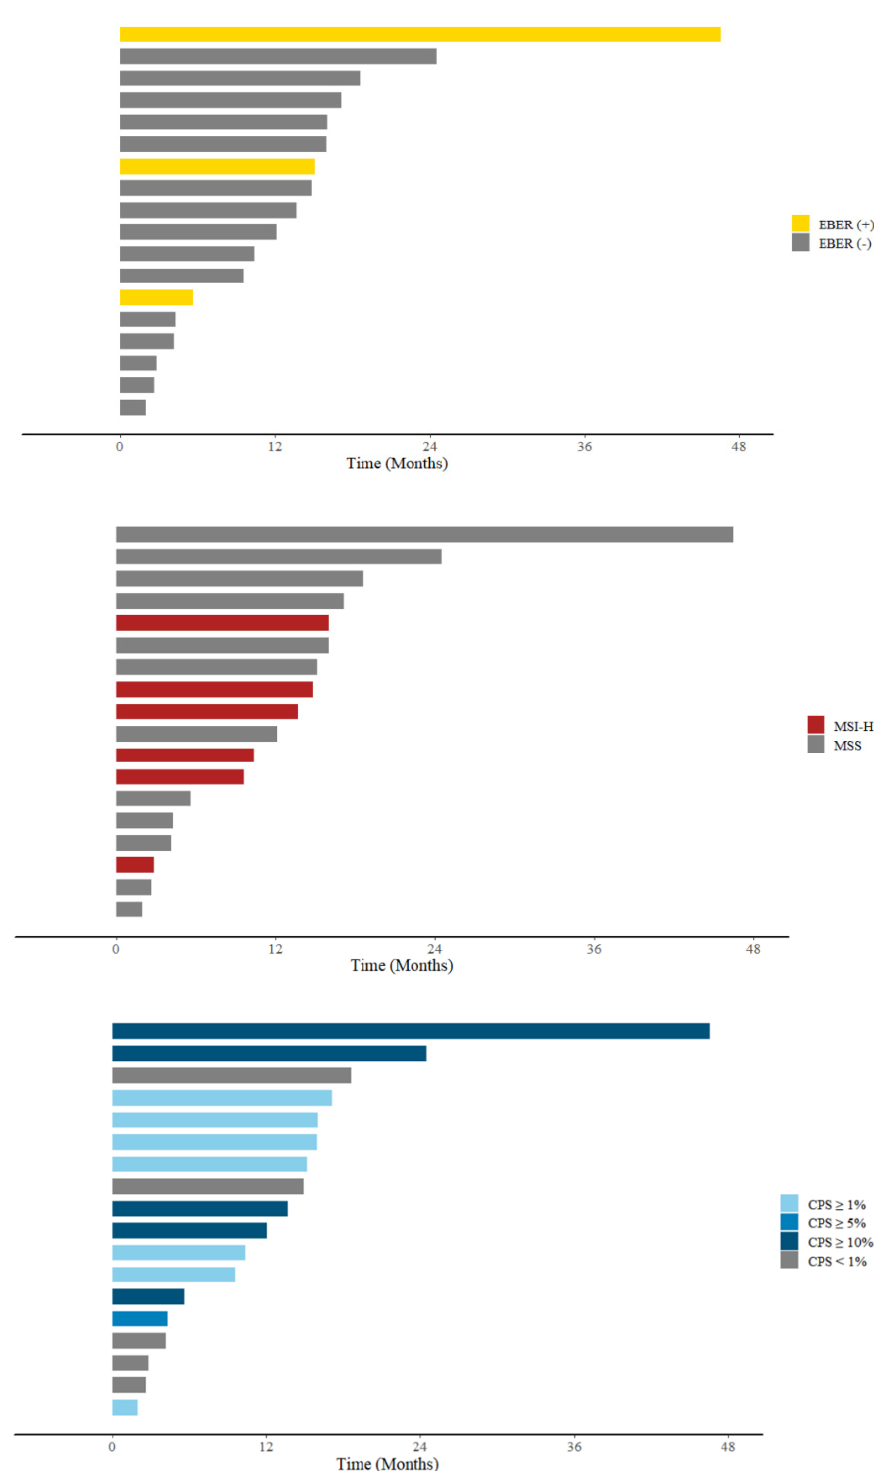
Figure 2. Timeline plot for durations of response, including patients with complete response and par- tial response. EBER: Epstein–Barr virus-encoded small RNAs; MSI-H: high microsatellite instability; PD-L1: programmed death ligand 1; CPS: combined positive score; PD: progressive disease.